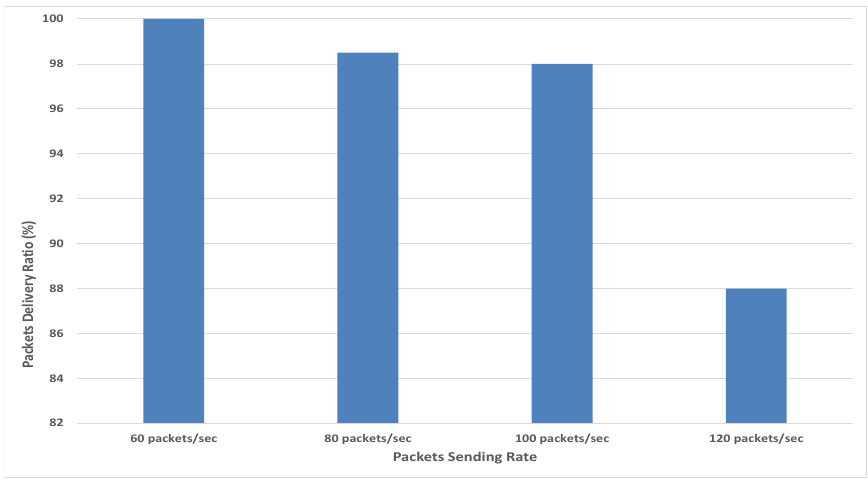
Figure 15. Packet delivery